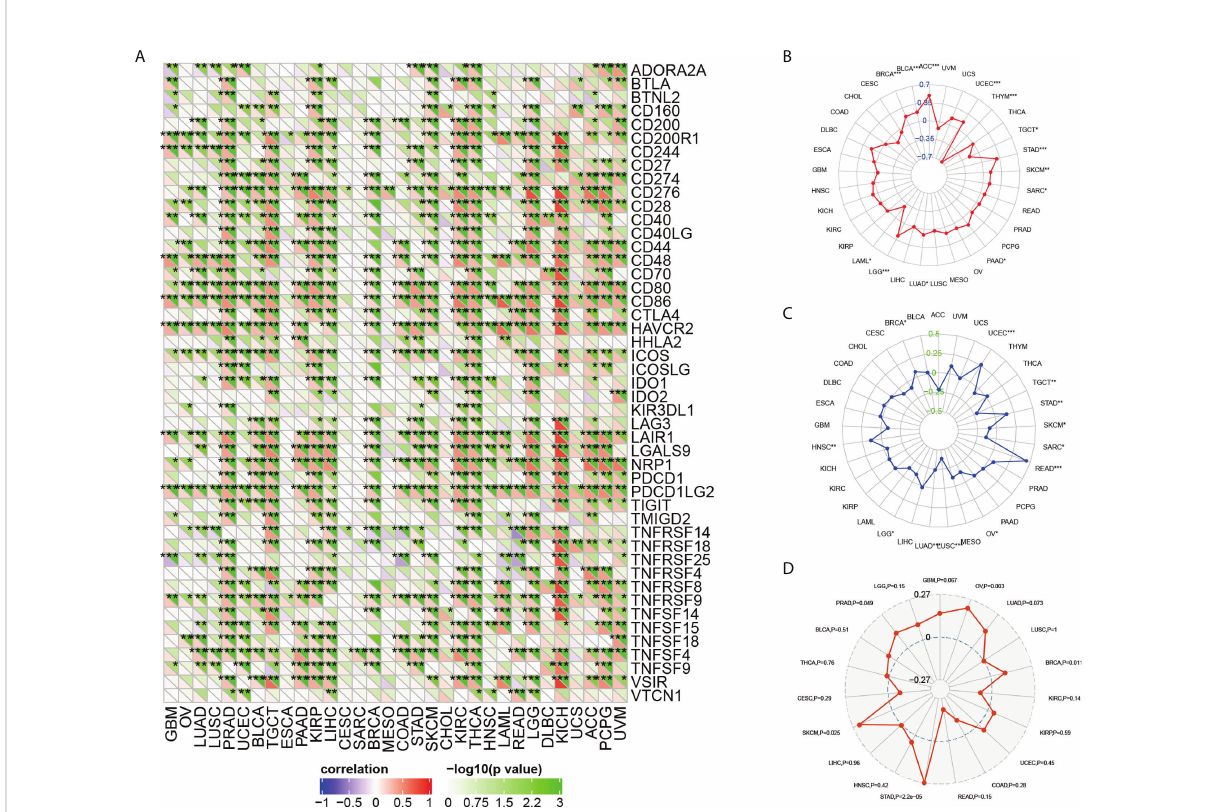
FIGURE 8 The relationship between ARPC5 and immune-checkmate inhibitors biomarkers in pan-cancer. (A) The heatmap showing the co-expression relationship between ARPC5 and 47 immune checkpoint – related genes. (B) Radar plot showing the relationship between ARPC5 and tumor mutation burden (TMB). (C) Radar plot showing the correlation of ARPC5 with microsatellite instability (MSI). (D) Radar plot showing the correlation of ARPC5 with neoantigens. The number in radar plot represents Spearman ’ s correlation coef fi cient. * p < 0.05; ** p < 0.01; *** p <